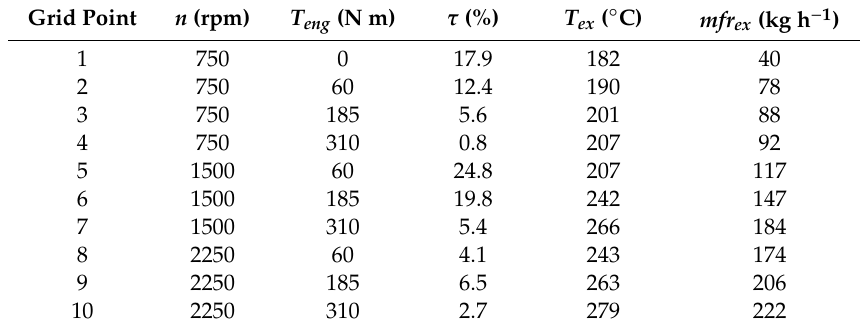
Table 2. Engine speed ( n ), torque ( T eng ), percent residence time ( τ ), exhaust gas temperature ( T ex ) and mass flow rate ( mfr ex ) for each grid point.